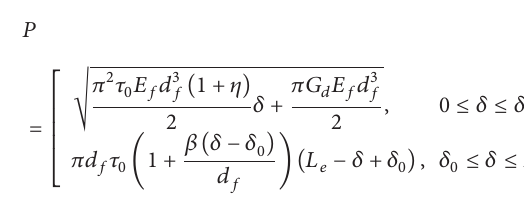
After reaching the peak pull-out load ( 𝑃 𝑎 ), the interface shear stress cannot be determined solely using the friction stress that results from the pulling-out process of the